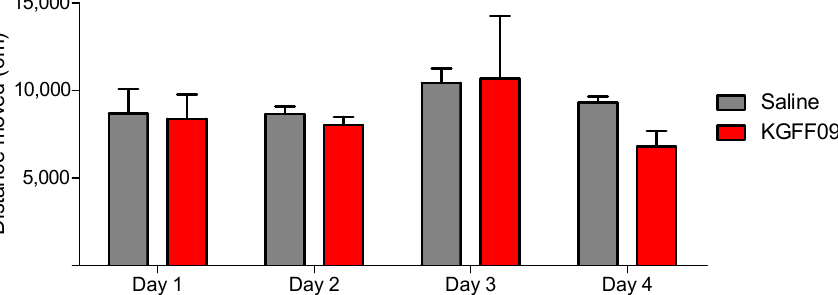
Figure 5. Effect of KGFF09 on spontaneous locomotor activity after chronic s.c. administration to mice using the open-field test. Mice were treated for 4 days with KGFF09 (7.4 µmol/kg) or saline and distance travelled in the open field was measured during 30 min. Values represent the mean ± SEM ( n = 8 mice per group).